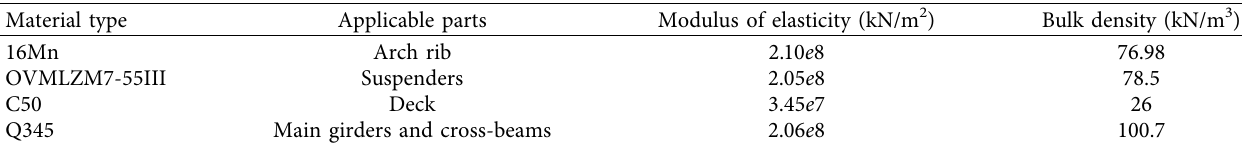
Table 1: Materials of the